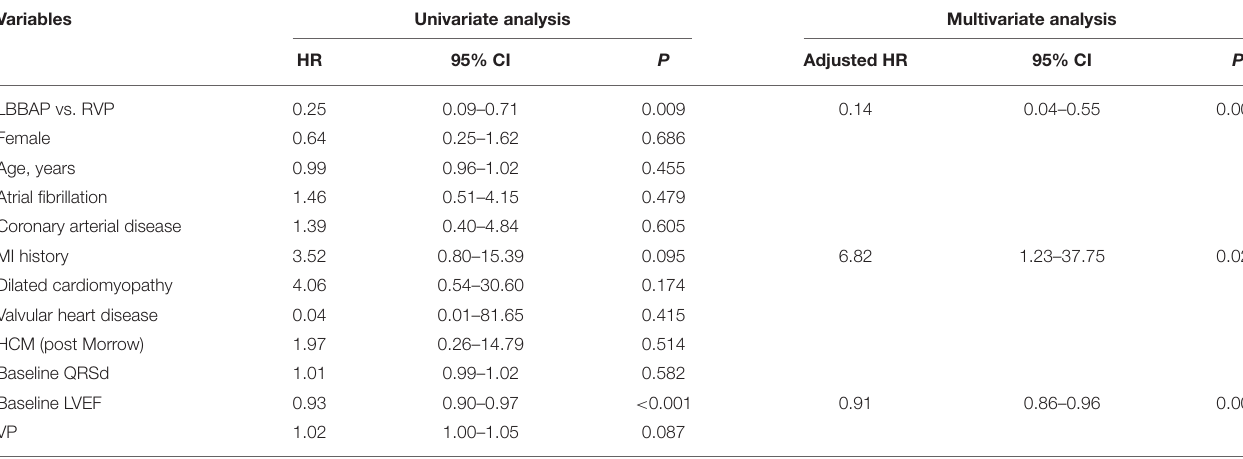
TABLE 5 | Univariate and multivariate Cox analyses for the composite outcome of HFH or upgrading to BiVP. Variables Univariate analysis Multivariate